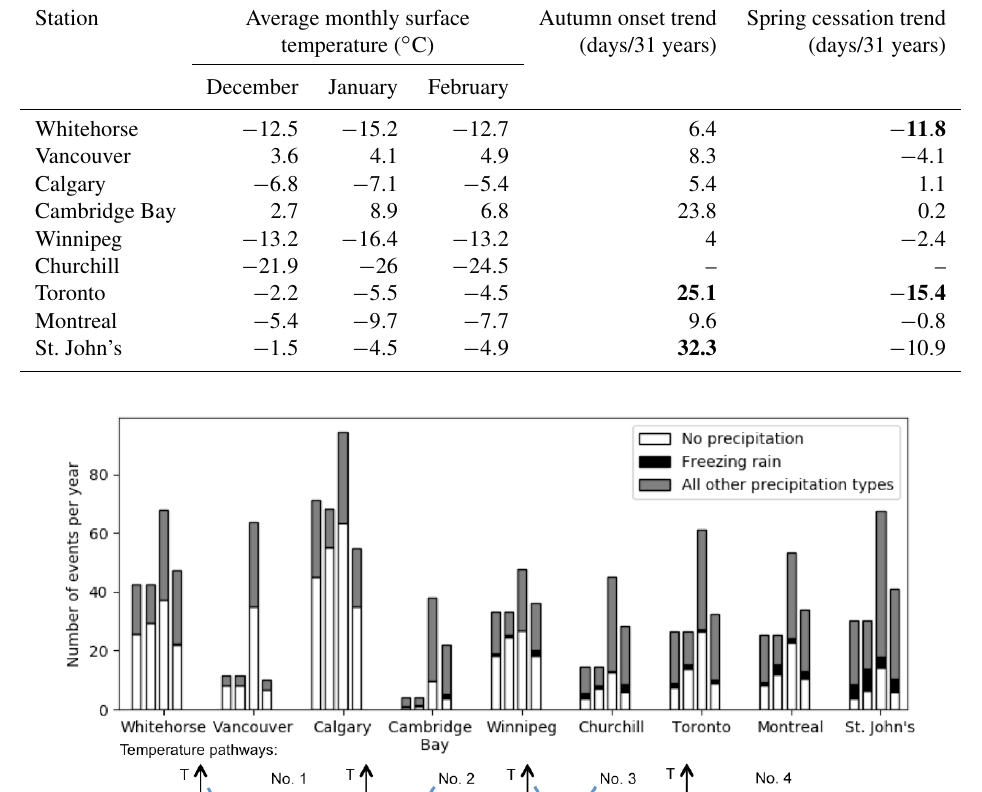
Table 4. Average monthly surface temperatures ( ◦ C) and trends (days/31 years) of the onset of near-0 ◦ C conditions in autumn and cessation in spring for the 1981–2011 period. For Cambridge Bay, average monthly values refer to June, July, and August, and trends refer to the cessation of near-0 ◦ C conditions in autumn and the onset in spring. No calculations were carried out at Churchill. Average monthly surface temperatures were obtained from ECCC for the 1981–2010 period (ECCC, 2019c). The numbers in bold indicate trends that are significant at the 5% level.